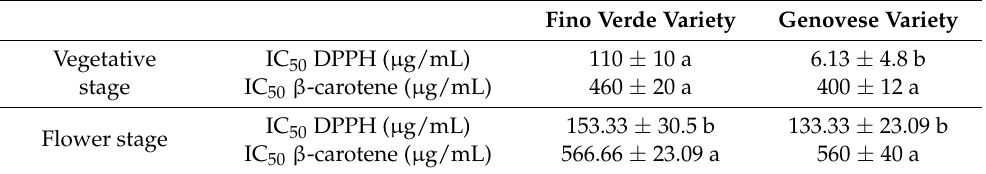
Table 3. DPPH activity and β -carotene content of two varieties in different stage. Values are represented by mean ± standard deviation of at least three independent replicates. Within the same stage, different letters on the bars indicate significant differences at p <